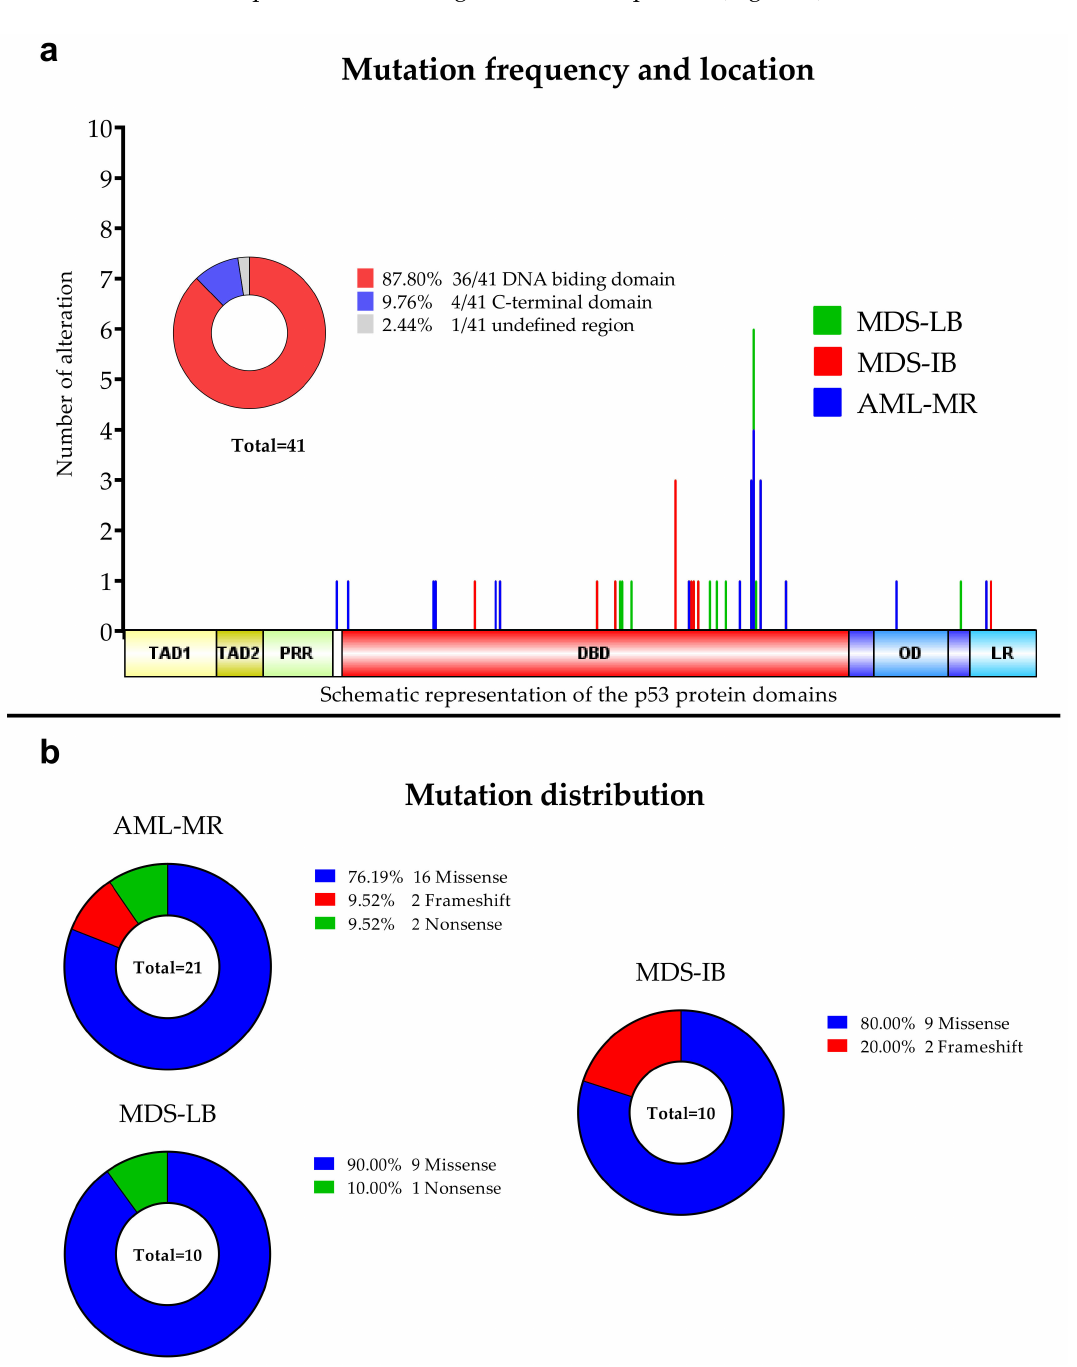
Figure 2. Detected TP53 aberrations using NGS. ( a ): Mutation frequencies in the three patients’ group. The locations of the detected alterations are shown for the p53 protein. ( b ): Distribution of the mutations among the three